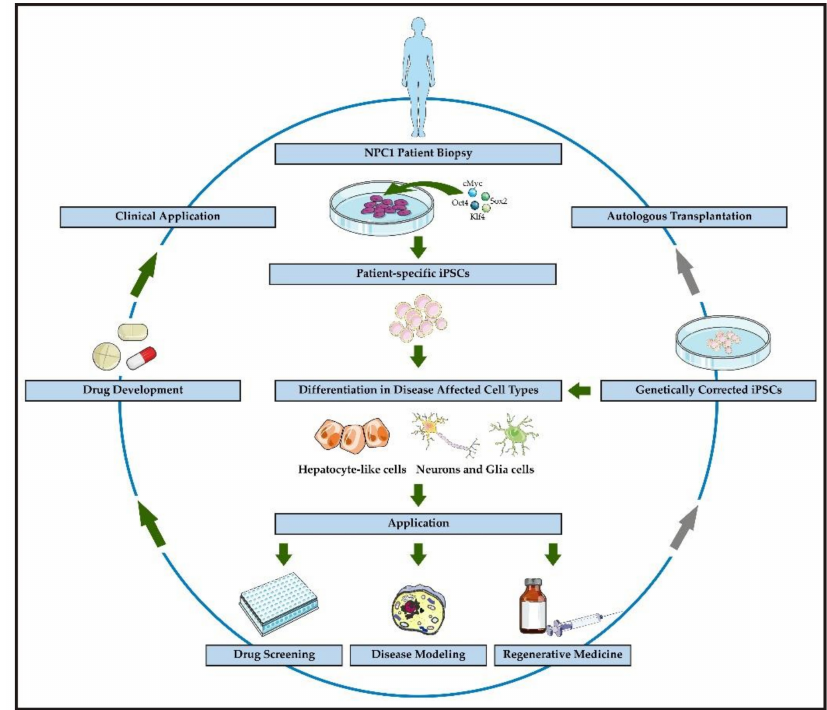
Figure 1. Schematic representation of the approaches using induced pluripotent stem cells (iPSCs) in the field of Niemann-Pick disease Type C1 (NPC1). Several studies describe the reprogramming of NPC1 patient-specific fibroblasts into disease-specific iPSCs, usually using the classical "Yamanaka factors". The majority of studies used neuronal cell systems derived from iPSCs. Currently, only two studies include hepatocyte-like cells derived from iPSCs. NPC1-deficient iPSC-derived cell types have been successfully used for disease modeling and drug discovery. Approaches to transplant genetically corrected cells have not yet been undertaken, but iPSCs with a TALEN-mediated correction of the NPC1 mutation have been used for disease modeling. Green arrows indicate successful technical approaches, grey arrows indicate theoretical curative approaches. (Graphic was composed using https://smart.servier.com). Please also refer to Table